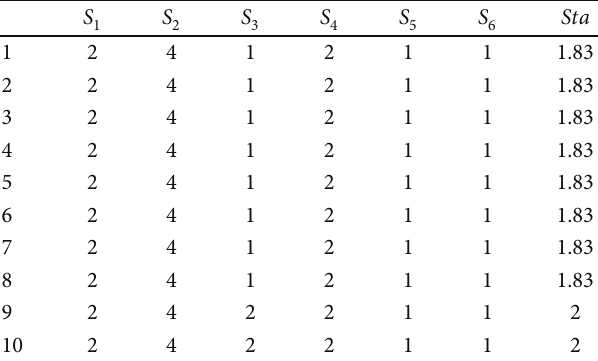
Table 2: Static structure calculation process of coal and